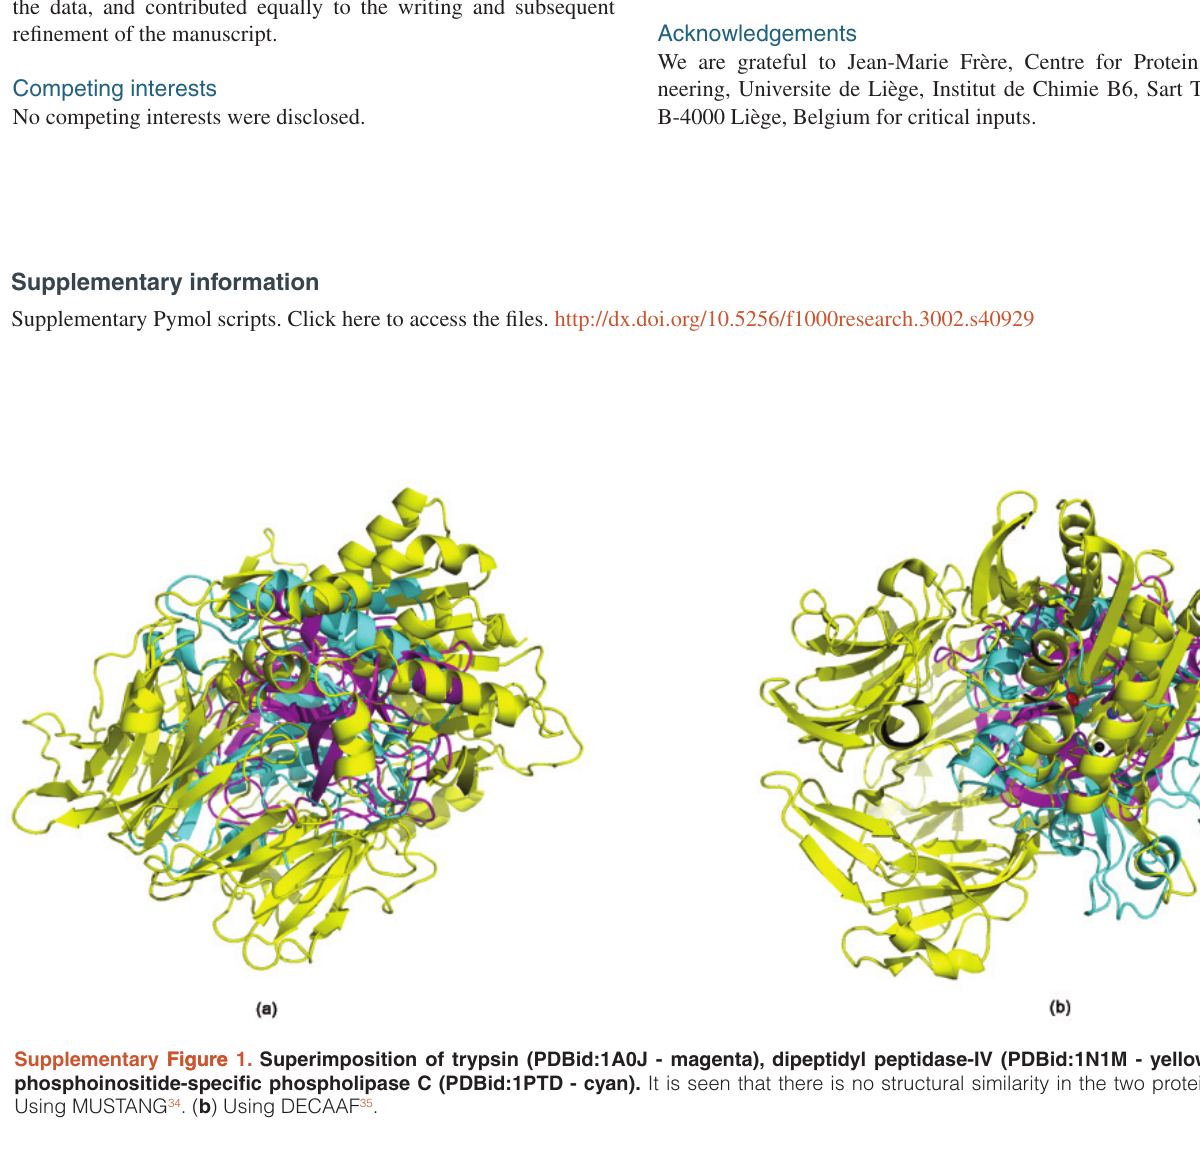
figshare: Phosphoinositide-specific phospholipase C inhibition data using the dipeptidyl peptidase-IV inhibitors K-579 and LAF- 237,